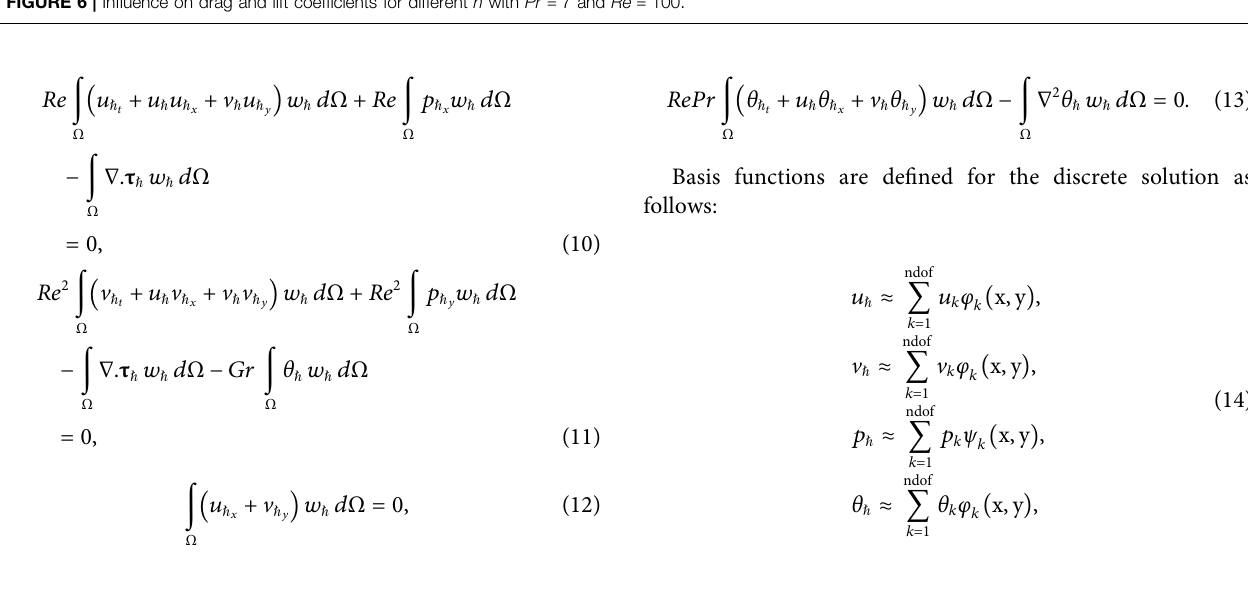
FIGURE 6 | In fl uence on drag and lift coef fi cients for different n with Pr (cid:2) 7 and Re (cid:2) 100.